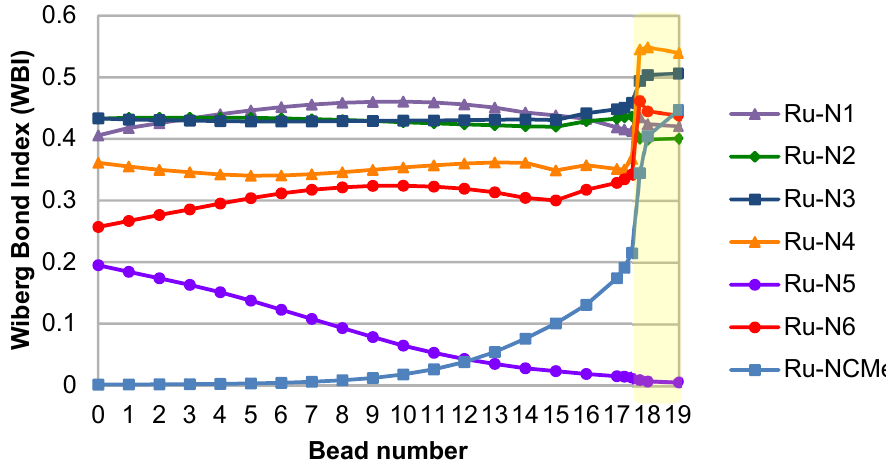
Figure 4. Evolution of WBIs along the reaction path. The MC–MLCT transition region is highlighted in yellow.